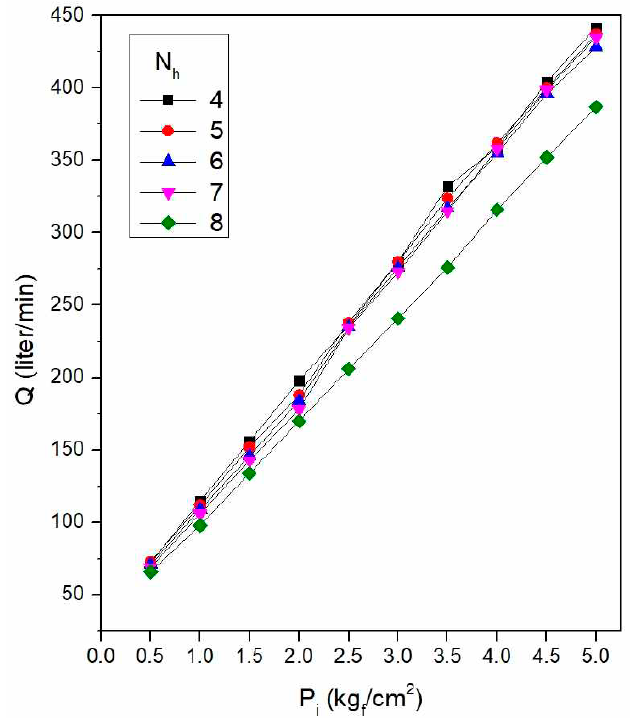
Figure 21. Total discharge flow rate of intake air pressure by the number of nozzles.